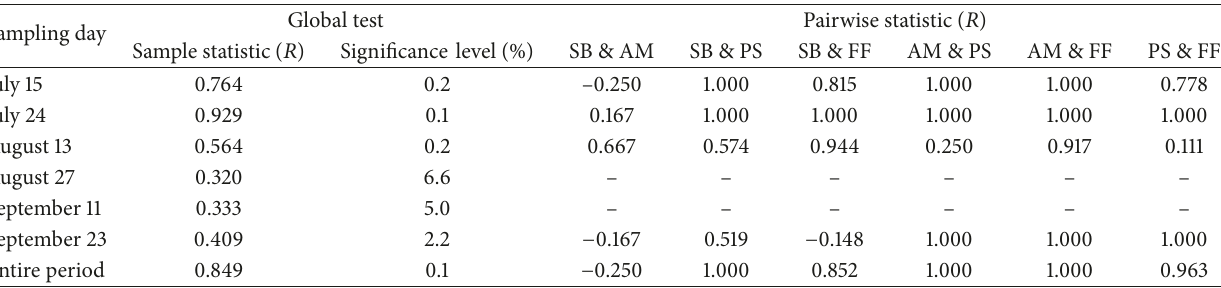
Table 2: Global test data and pairwise statistics derived by one-way analyses of similarities (ANOSIM) that explored differences in carabid beetle assemblages among the four habitats (six sampling dates) on Mt. Hakusan. All data were fourth-root transformed prior to ANOSIM analyses. 𝑅 denotes the Pearson correlation coefficient. The symbol “–” indicates that the pairwise test was not performed because the result of the global test was not significant ( ≥